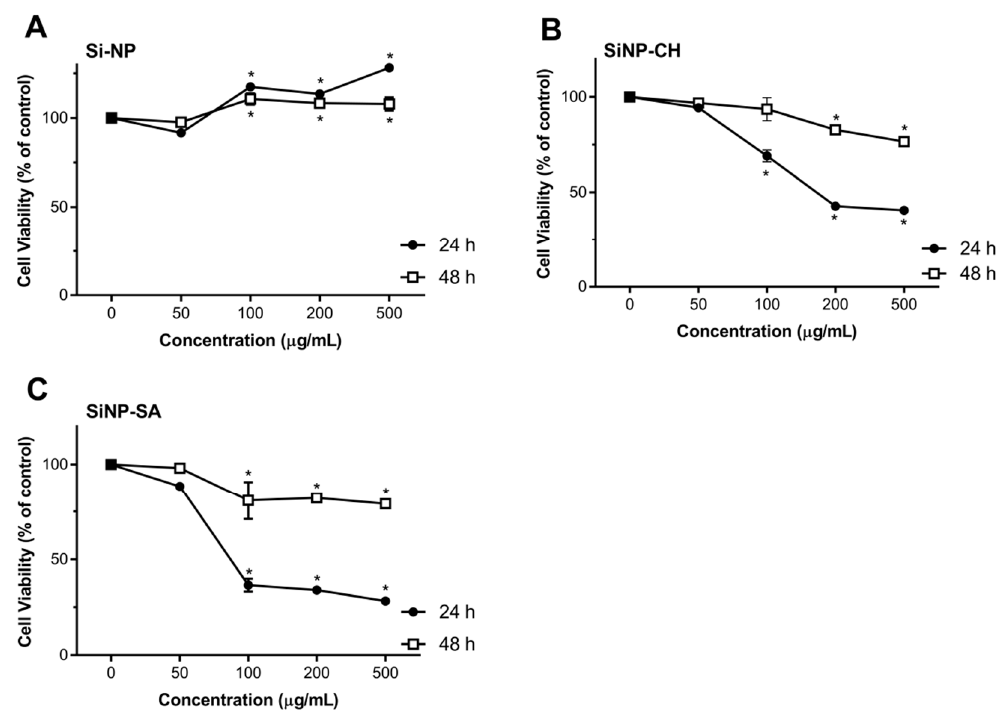
Figure 4. Effect of uncoated and coated SiNP on viability of Caco-2 cells after 24 or 48 h exposure to 50, 100, 200 and 500 µg/mL of SiNP ( A ), SiNP-CH ( B ) and SiNP-CH ( C ). Cell viability is expressed as % of control (n = 8) and data are presented as means ± SD. Statistical difference between control group and formulations is reported as * p ˂ 0.05.